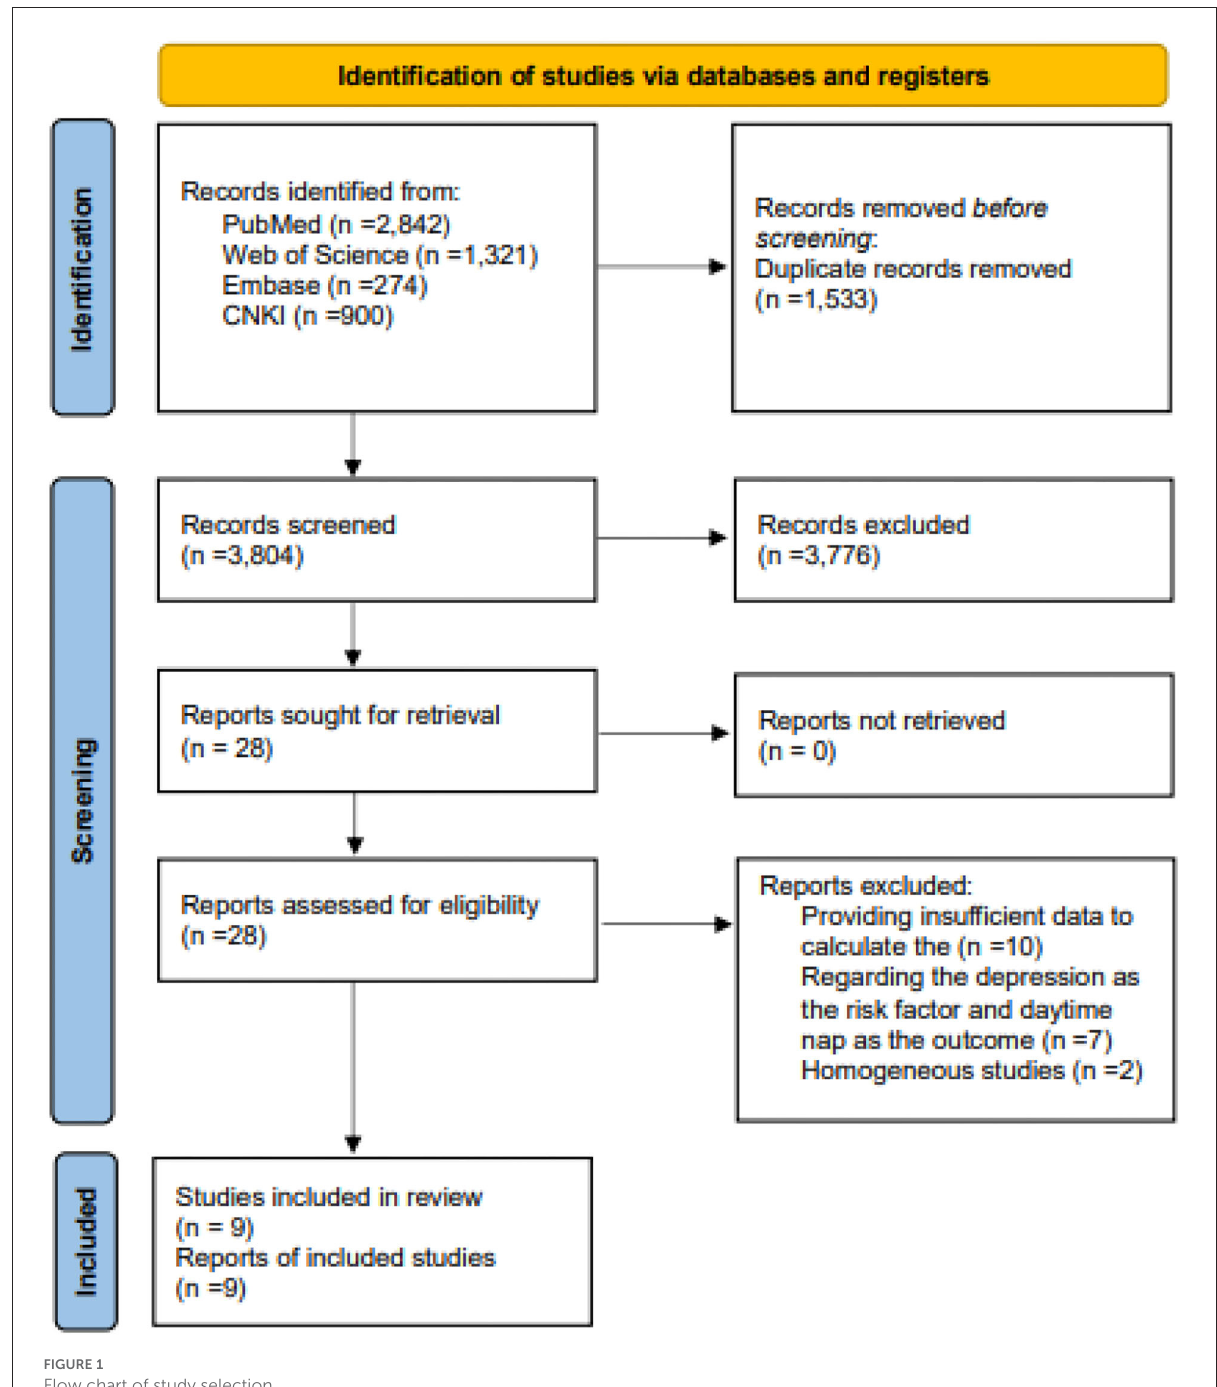
FIGURE1 Flow chart of study